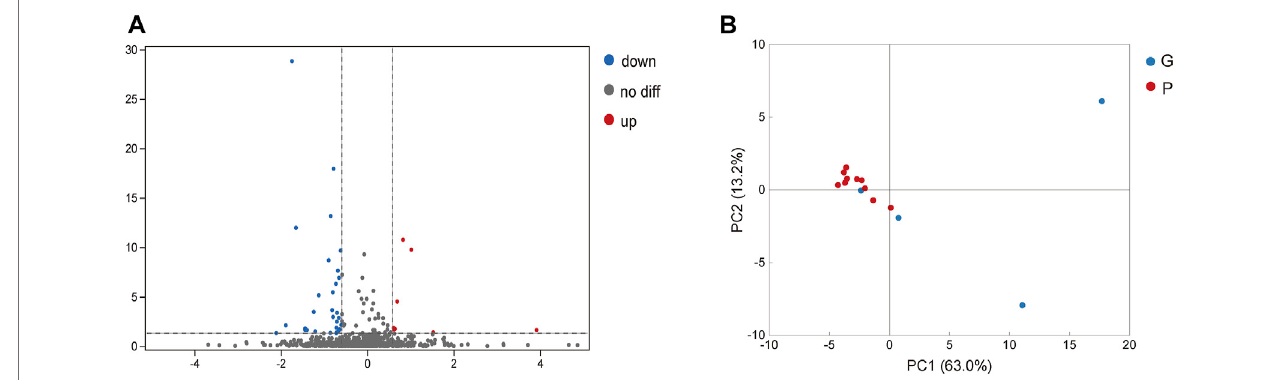
FIGURE 2 | Analysis of differentially expressed proteins in saliva. (A) Blue spot indicates the downregulated differently expressed protein, while red spot indicates the upregulated. Black spot represents the proteins with no different expression. Volcano-plot with a 5% FDR and limit of ± 1.5 in fold change in difference of mean quanti fi cation. (B) Blue spot indicates the differently expressed protein in G group, while red spot indicates the P group. PCA plot of individuals with G and P groups based on the differentially expressed proteins showed a partial separation of the groups.